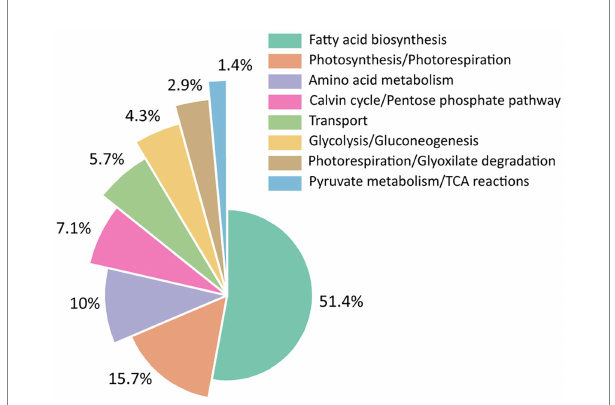
FIGURE 5 Distribution of reactions obtained with FSEOF algorithm based on functional subsystems. The reactions included in each subsystem are depicted in Supplementary Table S4.